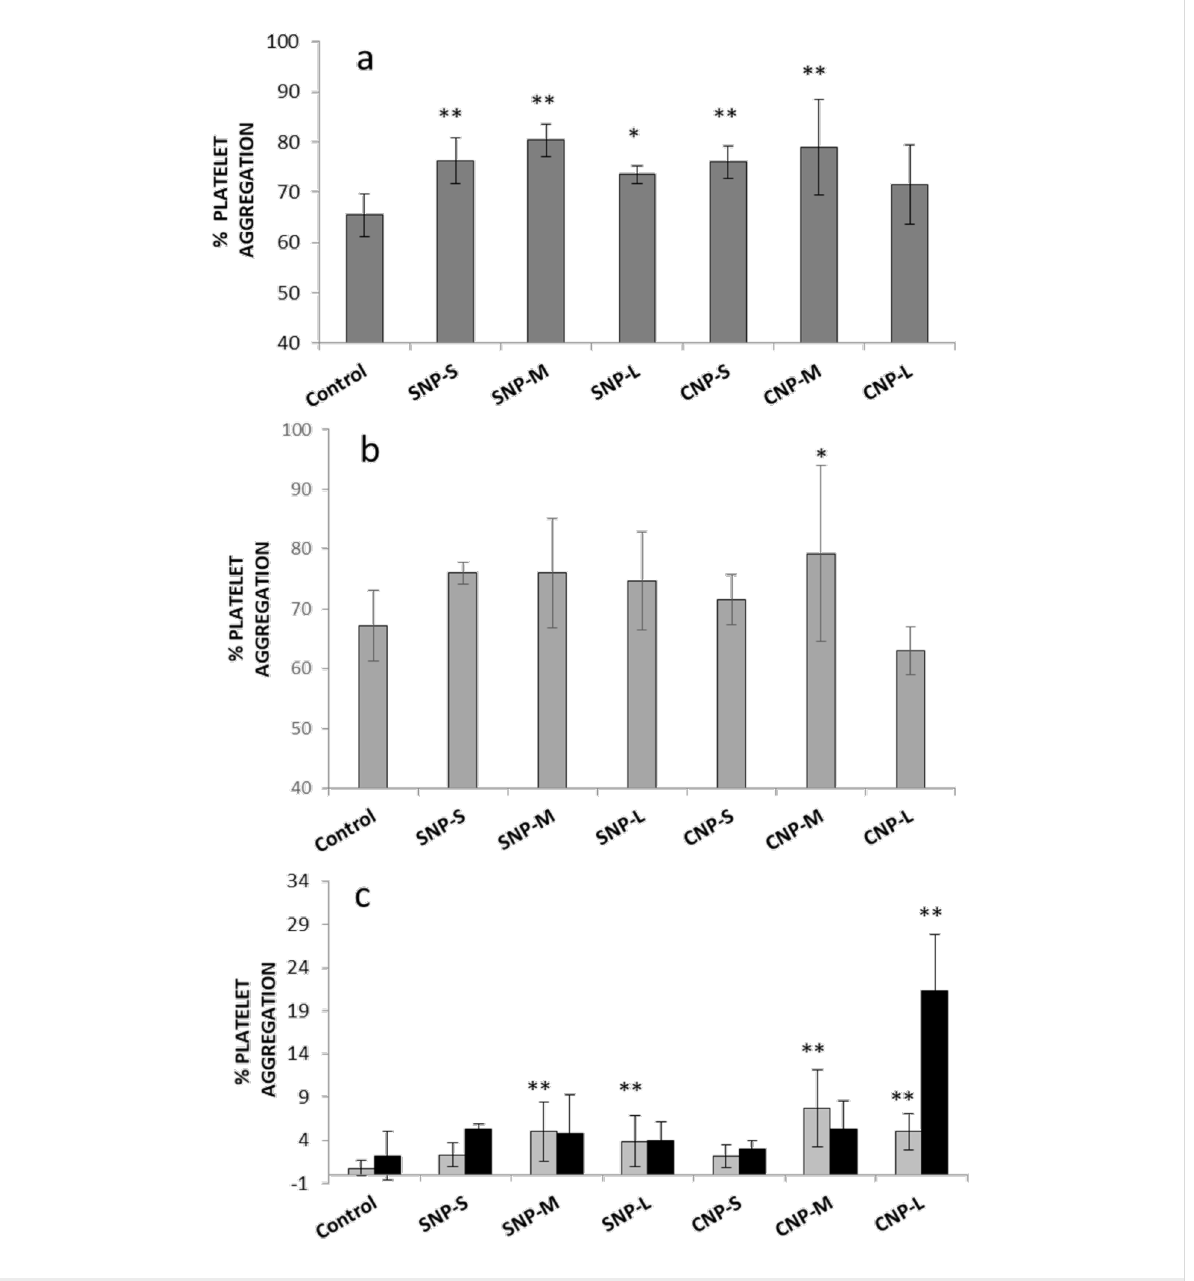
Figure 9: Effect of nanoparticles on platelet aggregation. a) Platelets activated by collagen; b) platelets activated by ADP; c) nonactivated platelets; after 5 (grey bars) and 40 (dark bars) minutes of incubation. ** p < 0.01, * p < 0.05.